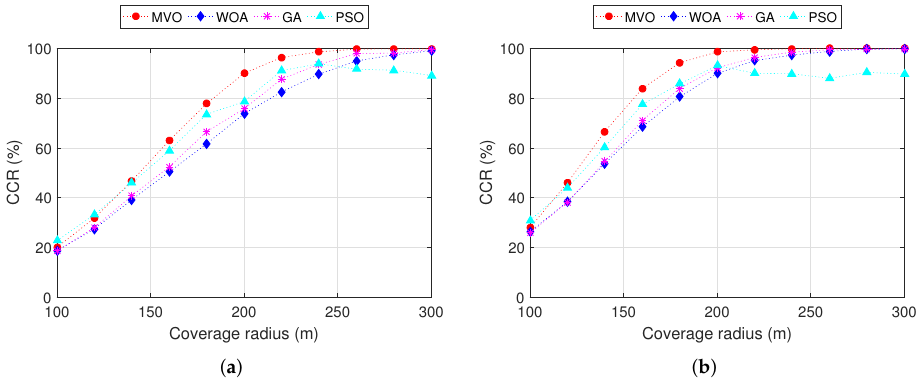
Figure 10. Performance comparison of the CCR versus the coverage radius of the routers. ( a ) INS-6. ( b )